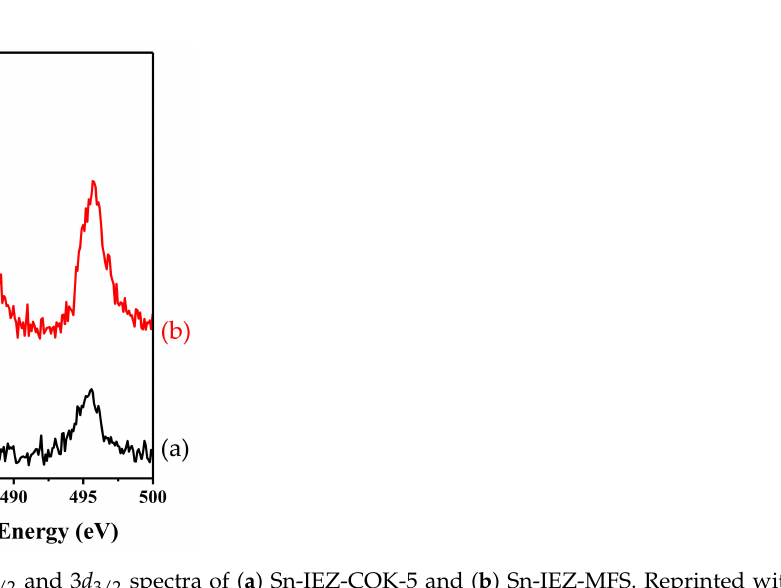
Figure 13. Sn 3 d 5/2 and 3 d 3/2 spectra of ( a ) Sn-IEZ-COK-5 and ( b ) Sn-IEZ-MFS. Reprinted with permission from ref. [55]. Copyright 2015, Elsevier.